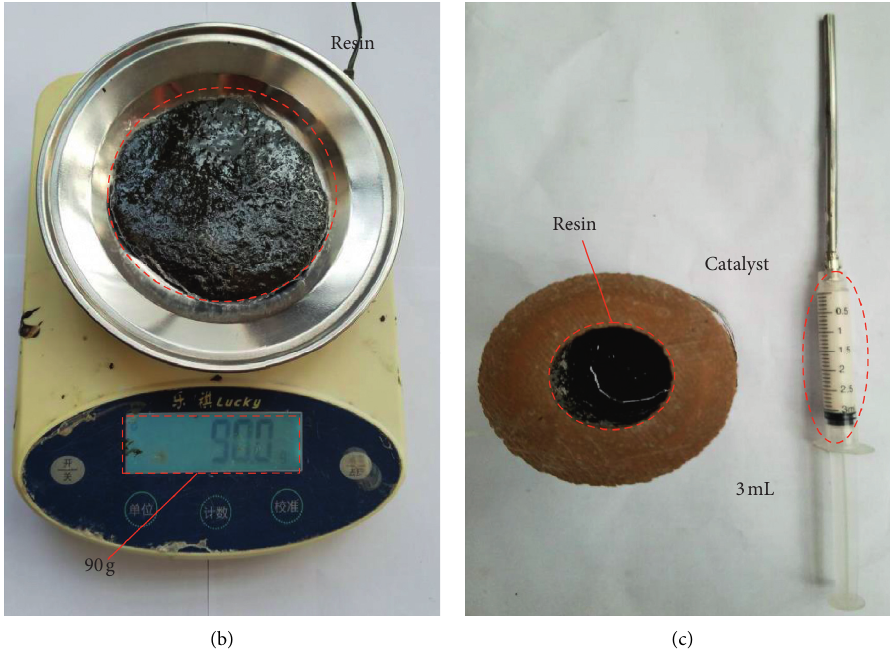
Figure 11: Photographs demonstrating the bolt, quantitative method for resin, and catalyst measurement: (a) bolt for pullout tests, (b) weighing the resin with a balance, and (c) the mixedness of resin and catalyst.